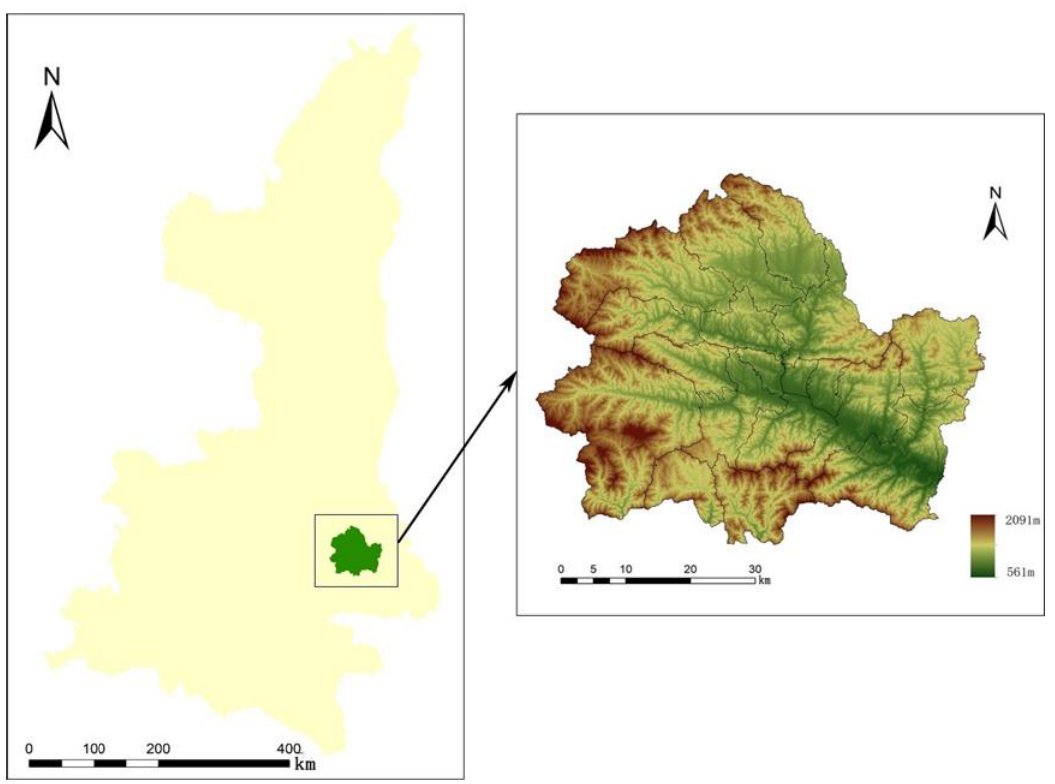
Figure 1. Location of Shangzhou district.